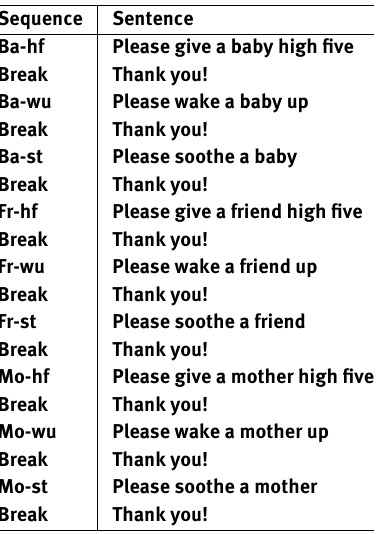
Table 1. Sequence of the virtual social situations (as they appear on the screen)